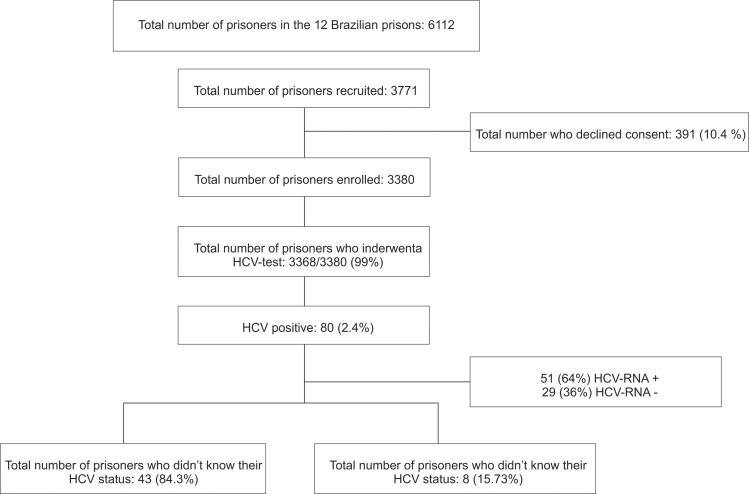
Flow chart of the recruitment of the study and screening process for HCV.